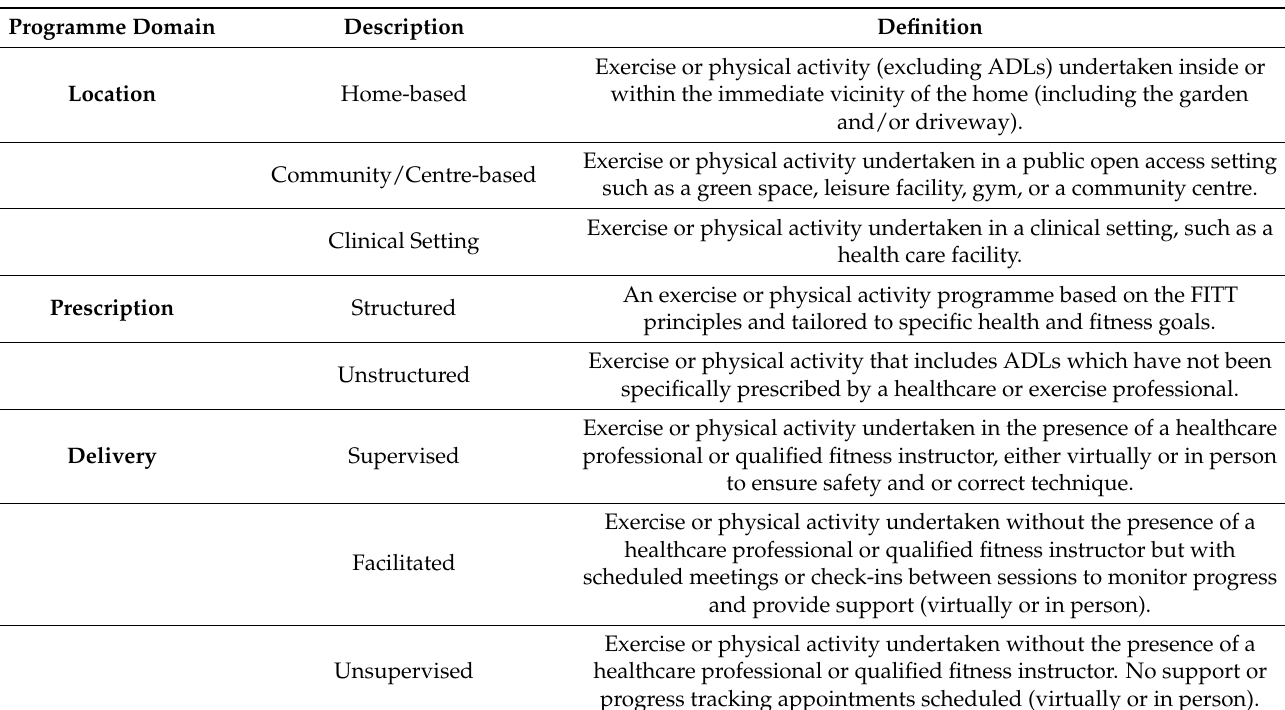
Table 1. Definitions for exercise and physical activity programme